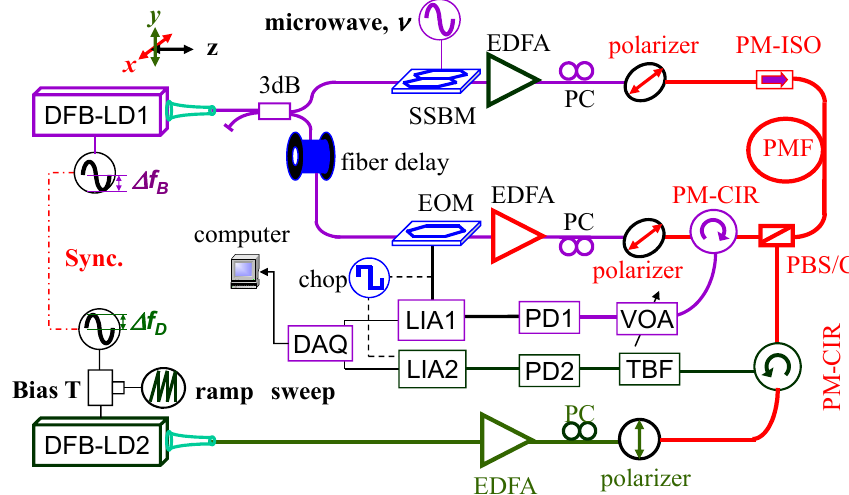
Figure 42. BOCDA system to measure strain and temperature distribution discriminatively along a PMF while measuring both the BFS and the BDG reflection